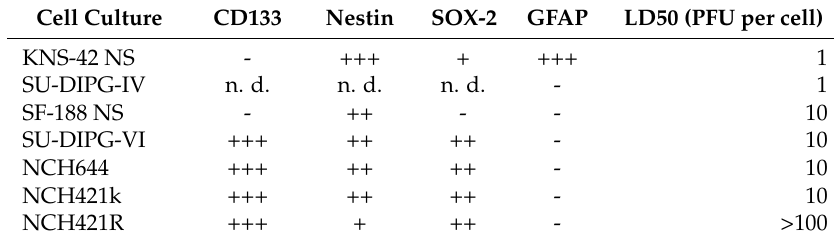
Table 2. Stem cell marker expression and 50% inhibition (LD50) oncolytic parvovirus H-1 (H-1PV) virus doses in high-grade glioma (HGG)